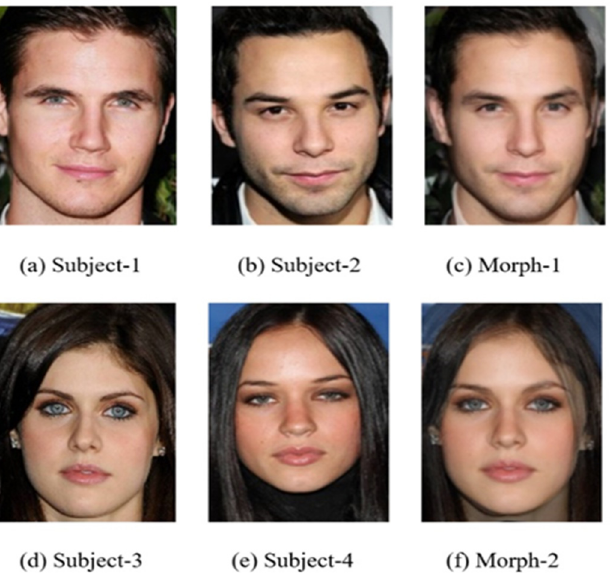
Figure 1. Morph-1 ( c ) is a morphed image created from Subject-1 ( a ) and Subject-2 ( b ). Morph-2 ( f ) is a morphed image created from Subject-3 ( d ) and Subject-4 ( e ). (Morphed images are created manually using the tool FotoMorph (2014) and Celebrity Database [6] Adapted from Chen et al. (2015).